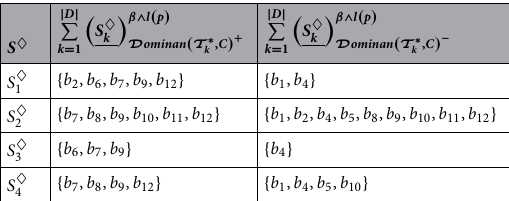
Table 12. The lower approximations with β = 0.90, l = 1 .